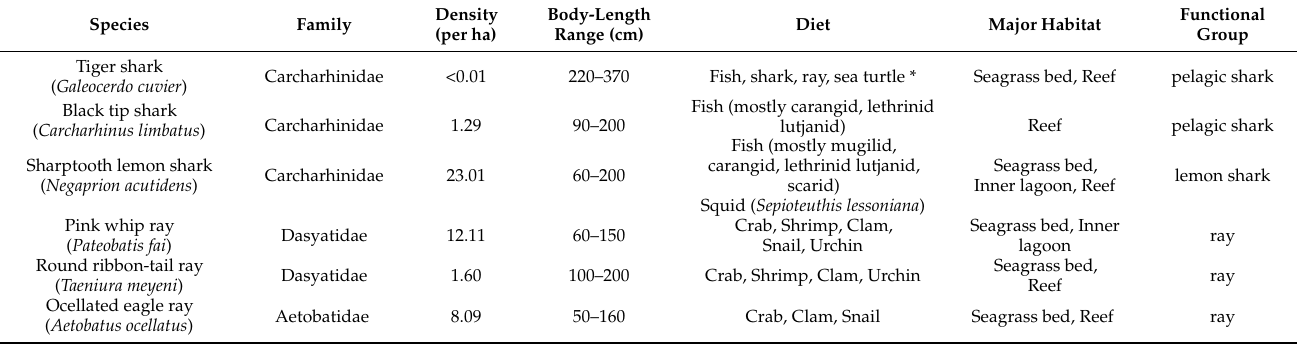
Table 4. Common elasmobranchs and their ecological information at